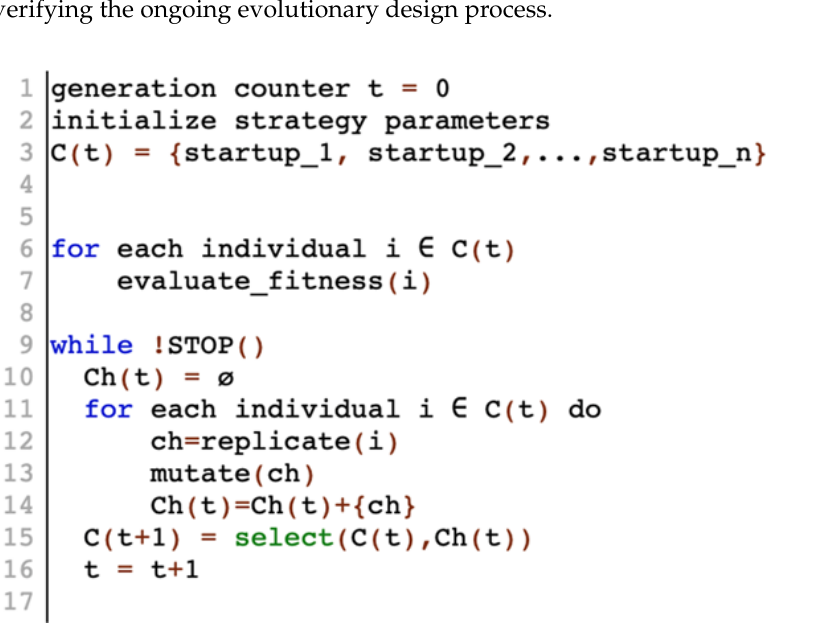
Figure 2. The pseudocode of the proposed EP algorithm.